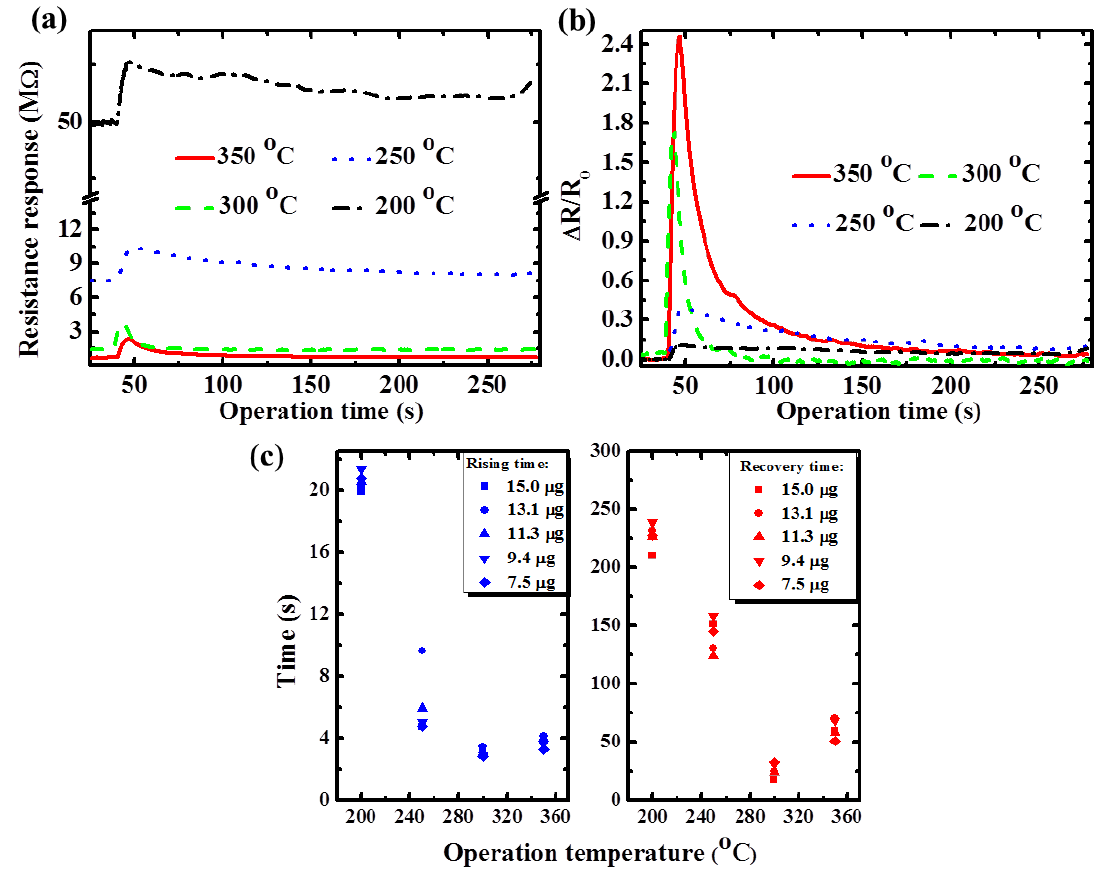
Figure 5. ( a ) Transient responses at various operation temperatures (with the injection absolute mass quantity of 7.5 μg); ( b ) normalized sensing responses at various operation temperatures of (a); and ( c ) reaction times of the TiO mass of 7.5 to 15.0